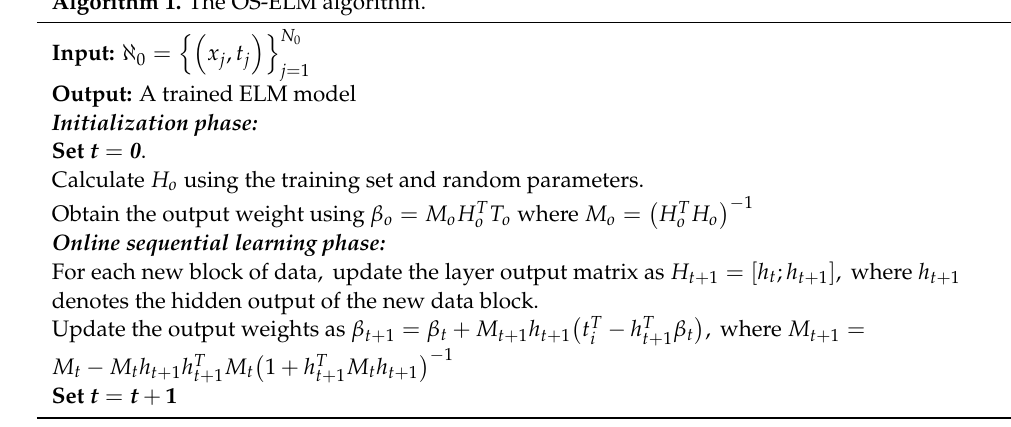
Algorithm 1. The OS-ELM algorithm.